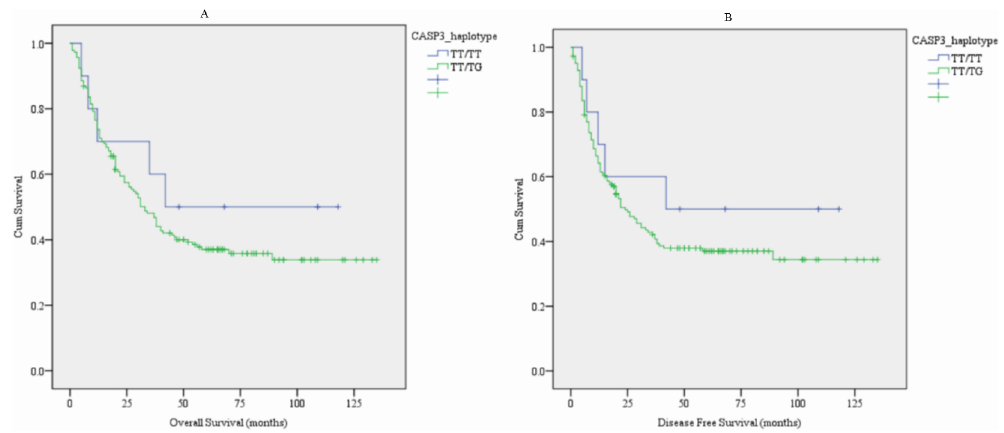
Fig 2. Kaplan-Meier survival curves of CASP3 _haplotype with clinical outcomes of HCC patients. (A) overall surviva l (OS), and (B) diseasefree survival (DFS).